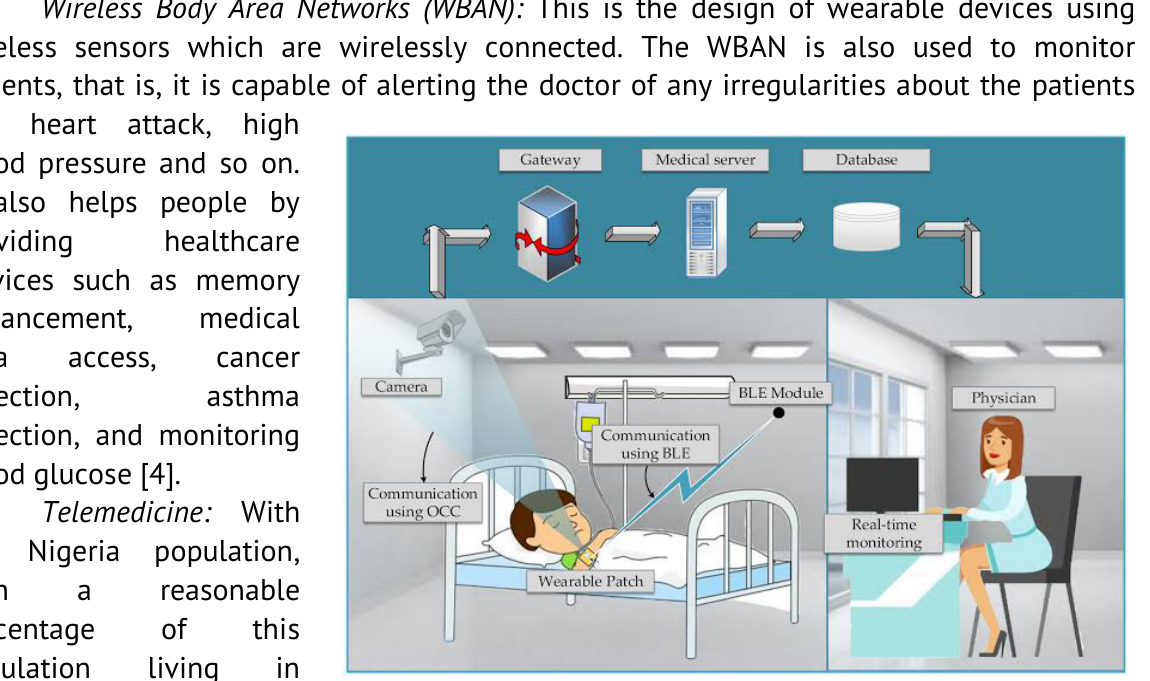
Figure 4. Patient monitoring system using